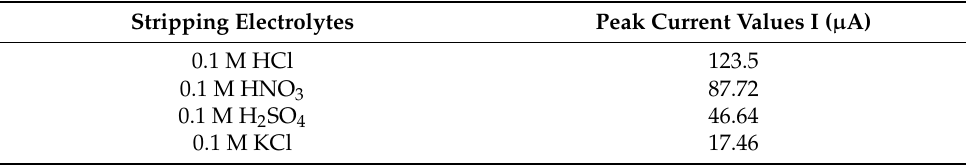
Table 1. Effect of different stripping electrolytes (0.1 M concentration) on peak current intensity for 10 µ g L − 1 Hg (II) solution at a deposition potential of − 0.7 V and 12 min accumulation time.